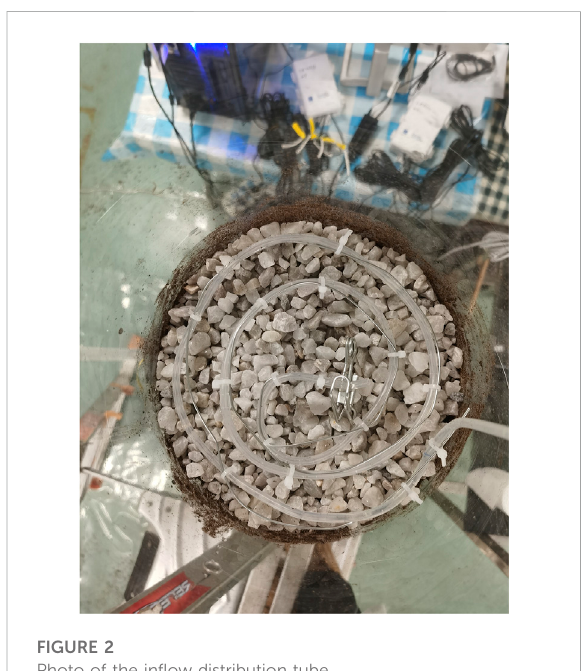
FIGURE 2 Photo of the in fl ow distribution